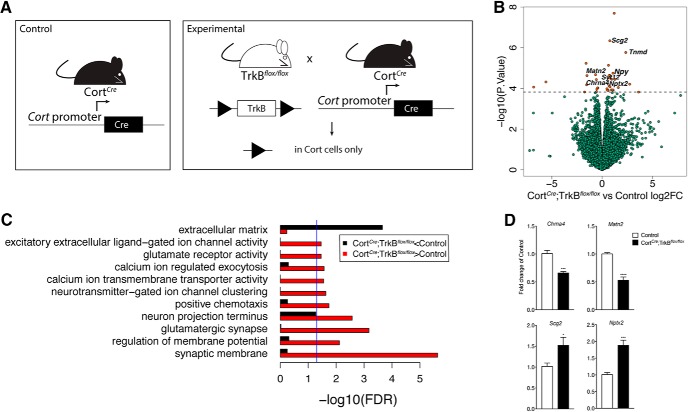
Loss of TrkB signaling in Cort interneurons causes gene expression changes in pathways regulating excitability. A, Schematic of control and CortCre;TrkBflox/flox mice. B, Volcano plot of bulk homogenate RNA-seq results with CortCre;TrkBflox/flox versus Control log2 fold change against −log10
p value. Orange dots represent genes that are significantly different in CortCre;TrkBflox/flox versus Control, including Npy, Syt12, Nptx2, and Chrna4. Green dots represent nonsignificant genes. See Extended Data Figure 1-1. C, GO terms in the molecular function, biological processes, and cellular component categories for genes enriched and de-enriched in cortical tissue following ablation of TrkB in Cort neurons. See Extended Data Figure 1-2. D, qPCR analysis validating genes found to be differentially expressed in bulk cortical homogenate RNA-seq of CortCre;TrkBflox/flox versus Control mice (n = 5 per genotype, Student’s unpaired t test; data are presented as the mean ± SEM: *p < 0.05 ***p < 0.001 ****p < 0.0001 vs control).